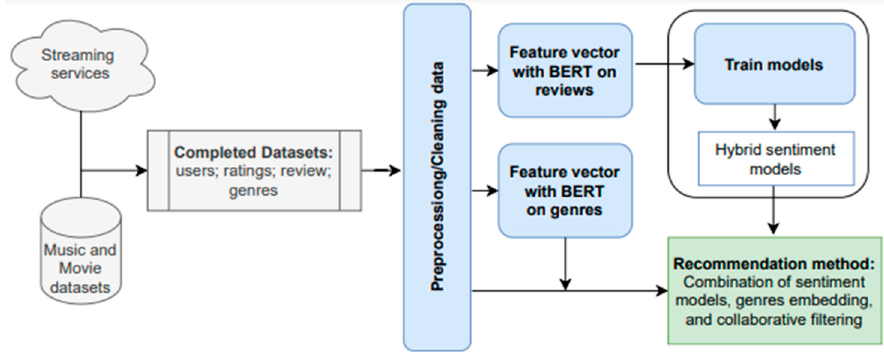
Figure 2. Architecture of recommender systems for streaming services based on hybrid deep learning models of sentiment analysis and item genres.